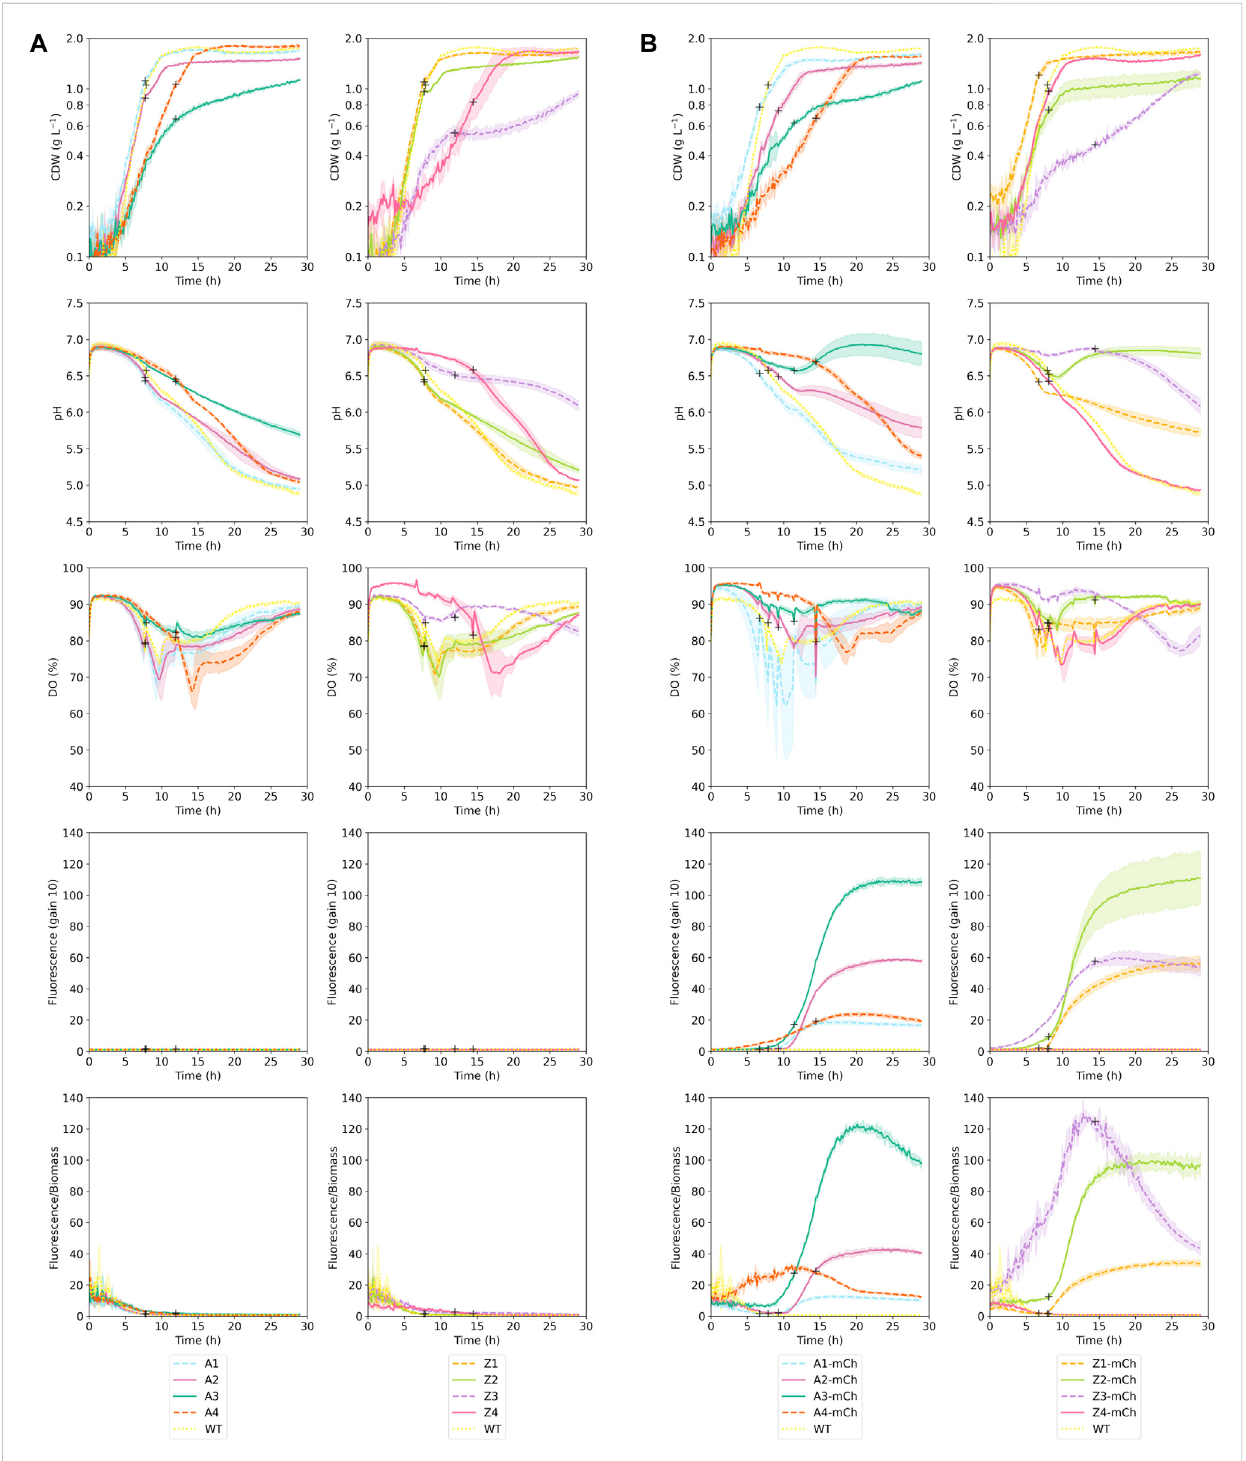
FIGURE 1 Cultivation parameters obtained during Biolector Pro cultivations. The plots display biomass (g CDW L -1 ), pH, dissolved oxygen (DO; %), absolute fl uorescence detected with gain 10, and fl uorescence/biomass ratios for each of the seventeen strains that were studied. The plots correspond to three independent biological replicates per strain; averages are indicated with a colored line and standard deviations (SD) are shown as a shaded area around theaverages of thesamecolor. Measurements wereperformed automaticallyevery 10 min. All cultivationswere carried out at30 ° C, 1,400 rpmand 85% humidity until Biomass reached 30 arbitrary units (approximately 0.7 g CDW L -1 ); at Biomass 30, temperature was reduced to 25 ° C and protein production was induced by adding 1 mM m-toluate. Protein production induction points are marked in the fi gure with black + signs (A) Panels correspond to strains that did not include mCherry gene (empty plasmid control strains) (B) panels show mCherry-producing